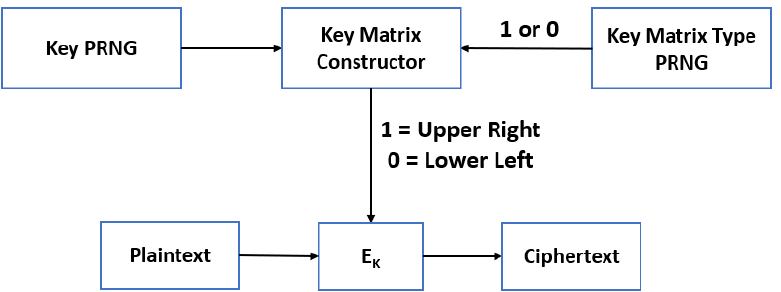
Figure 11. Illustration of alternating key matrix construction to achieve maximal